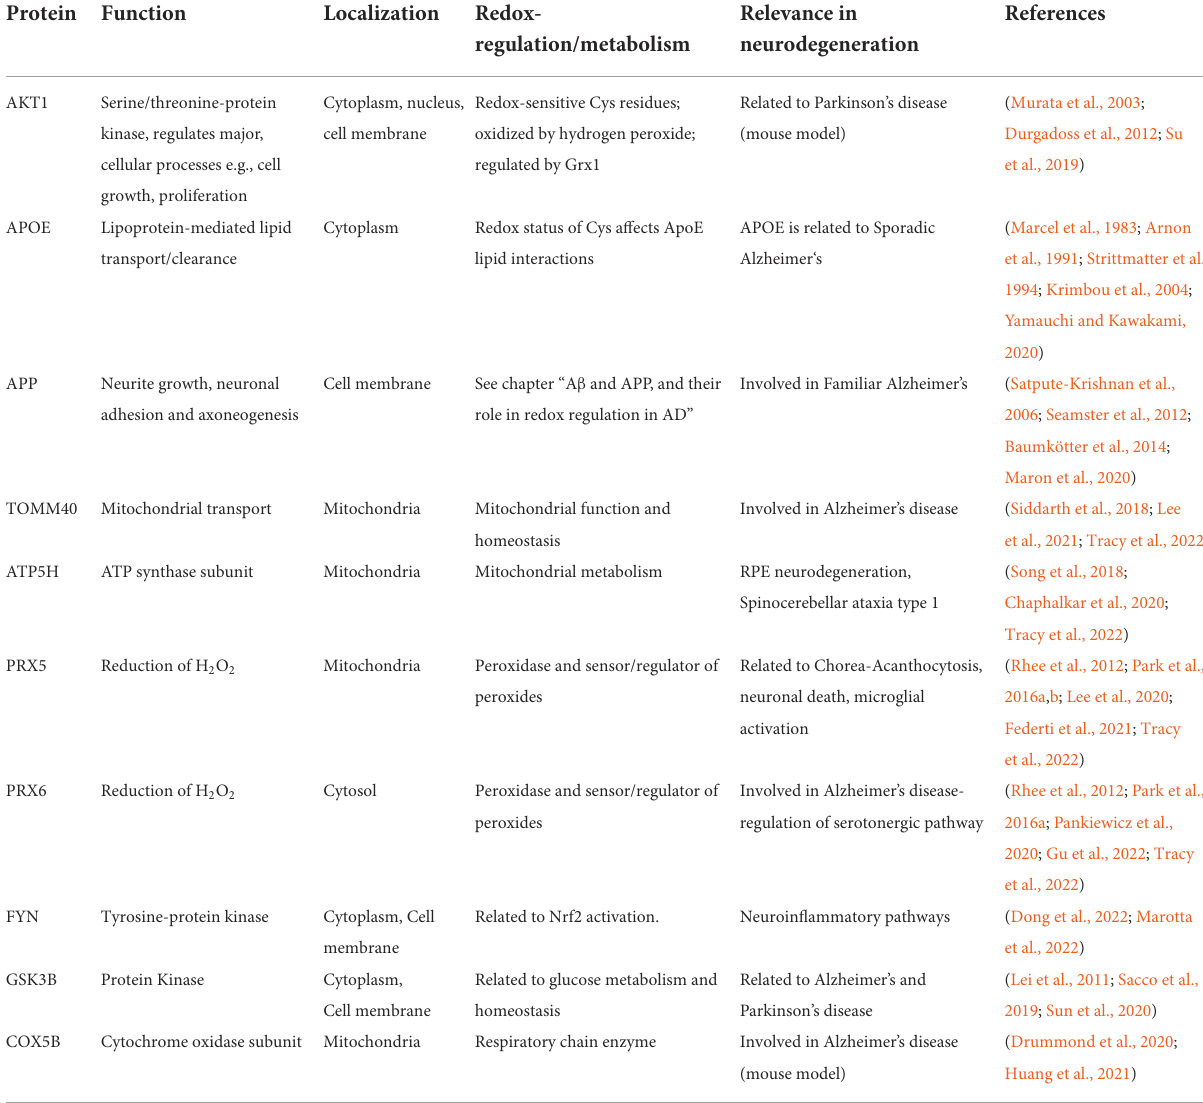
TABLE 1 List of redox regulated Tau interaction partners, their function(s), localization, as well as a link to redox regulation and metabolism. Protein